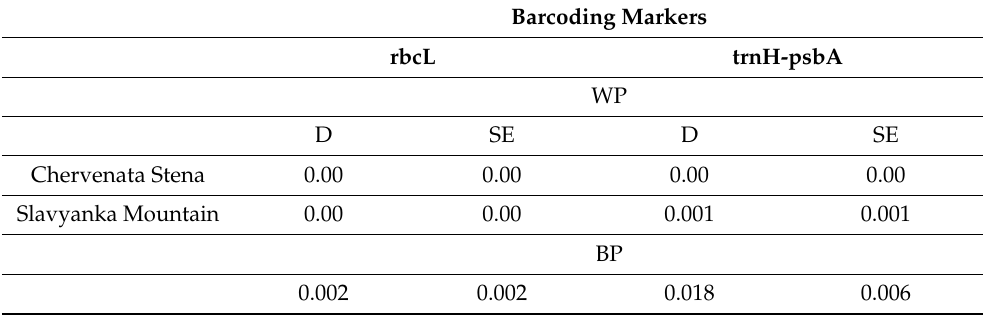
Table 2. Estimates of evolutionary divergence (D) between populations (BP) and within populations (WP) Chervenata Stena and Slavyanka Mountain. The number of base substitutions per site, obtained by averaging the overall sequence pairs between groups, are shown, along with standard errors. Analyses were conducted using the Tamura 3-parameter model implemented in MEGA-X. Barcoding Markers rbcL trnH-psbA WP